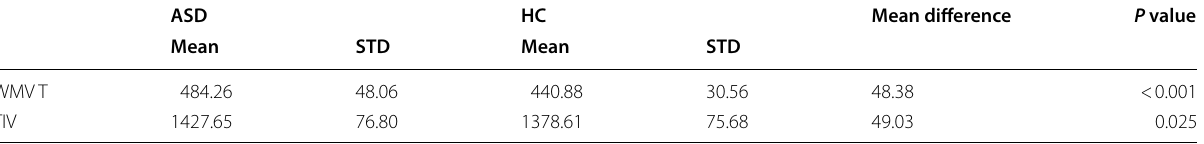
ASD Autism Spectrum Disorder, HC Healthy Controls, STD Standard Deviation, WMV T White Matter Volume Total, TIV Total Intracranial